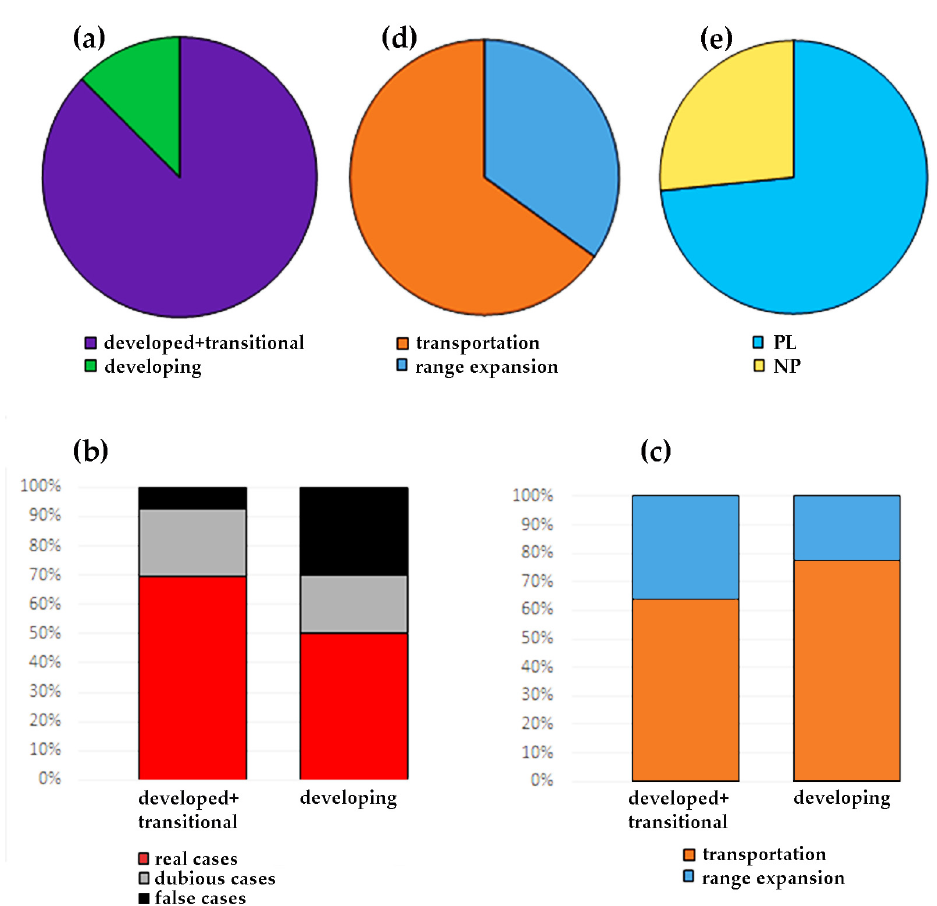
Figure 2. Analysis of data on non-indigenous taxa of Cladocera from our literature study (79 cases, 61 taxa; see Appendix A). ( a ) Proportion of cases of revealed transportation+range expansion in developed+transitional vs. developing countries; ( b ) Proportion of true, dubious and false identification of non-indigenous taxa in developed+transitional vs. developed countries; ( c ) Rate of cases of transportation vs. range expansions in developed+transitional vs. developed countries; ( d ) Global proportion of transportation vs. range expansion cases; ( e ) Rate of planktonic (PL) vs. non-planktonic (NP) taxa recorded as non-indigenous elsewhere.